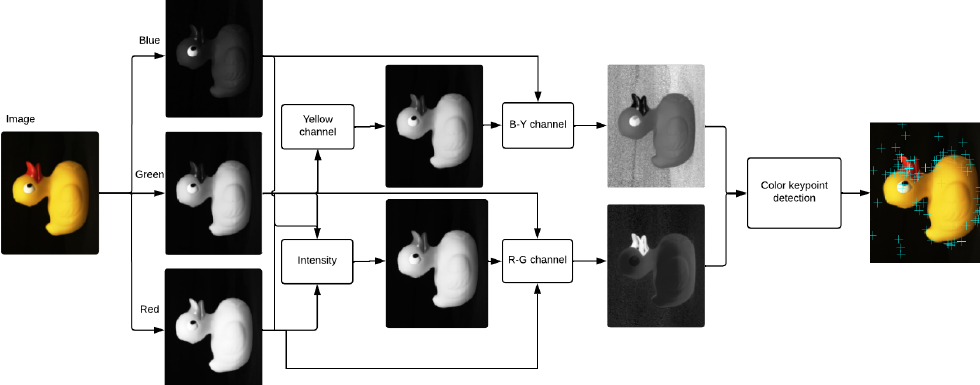
Figure 4. The pipeline of the Co-SIFT